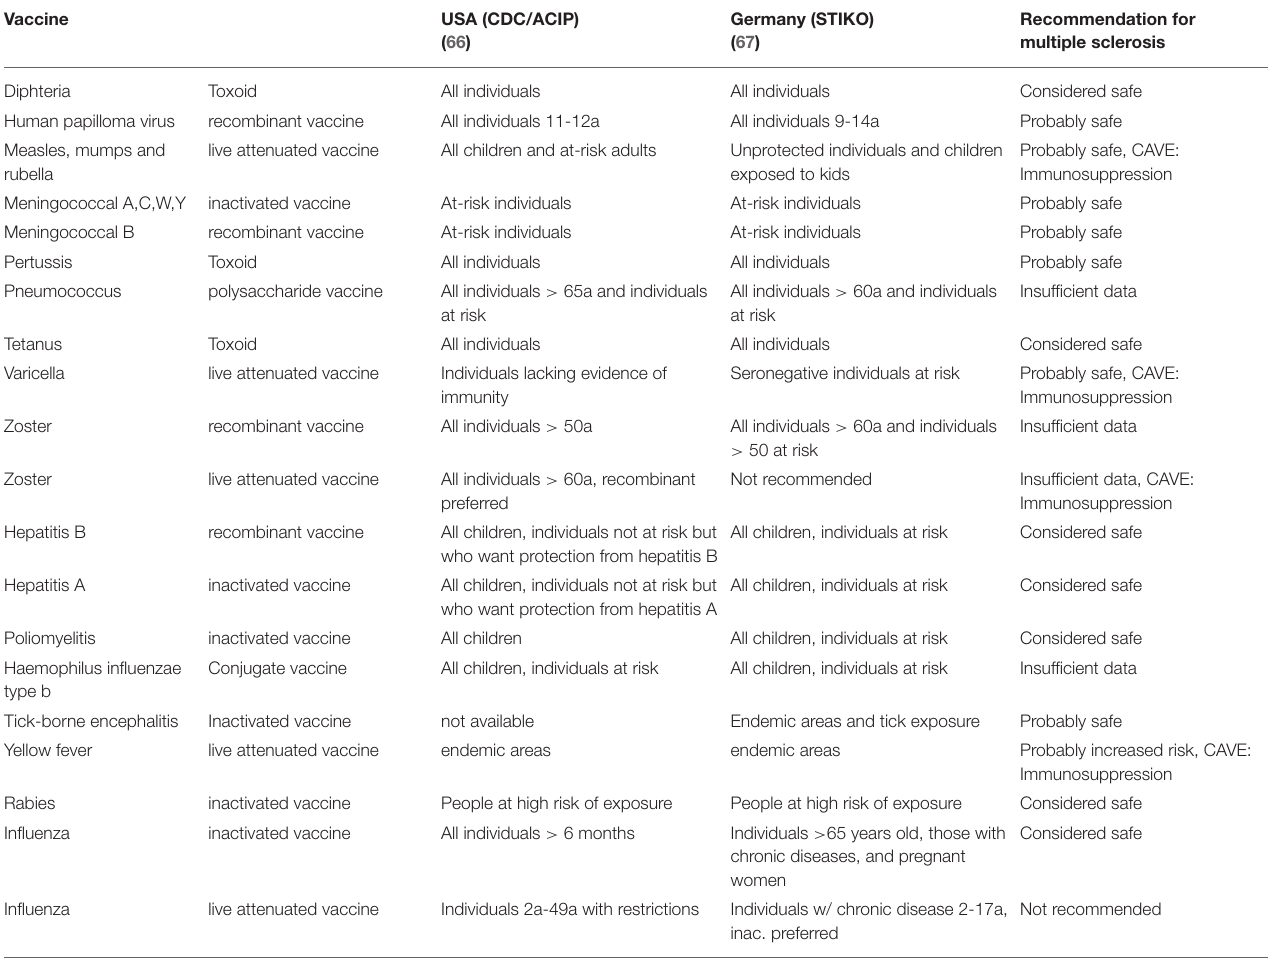
TABLE 1 | Overview of standard vaccination in the general population and MS patients.